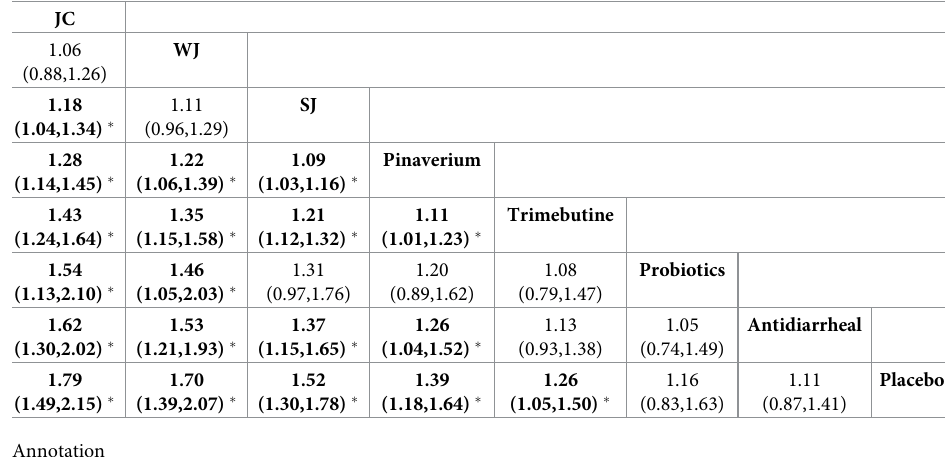
Table 4. Risk ratio with 95% confidence interval of adequate